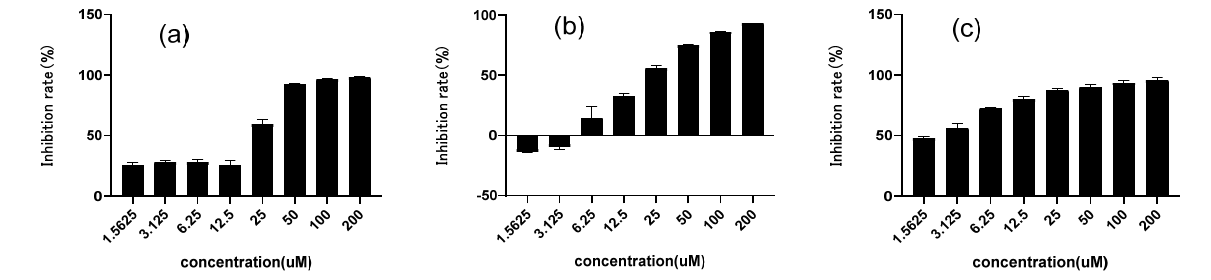
Figure 2. Inhibitory activity of three compounds against α -glucosidase. ( a ) Chalcomoracin; ( b ) 1-Deoxynojirimycin (DNJ); ( c ) acarbose. Data indicated as means ± SD ( n = 3).